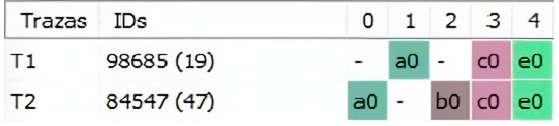
Figure 13. Sequences with check cancellations without prior suppression of products.